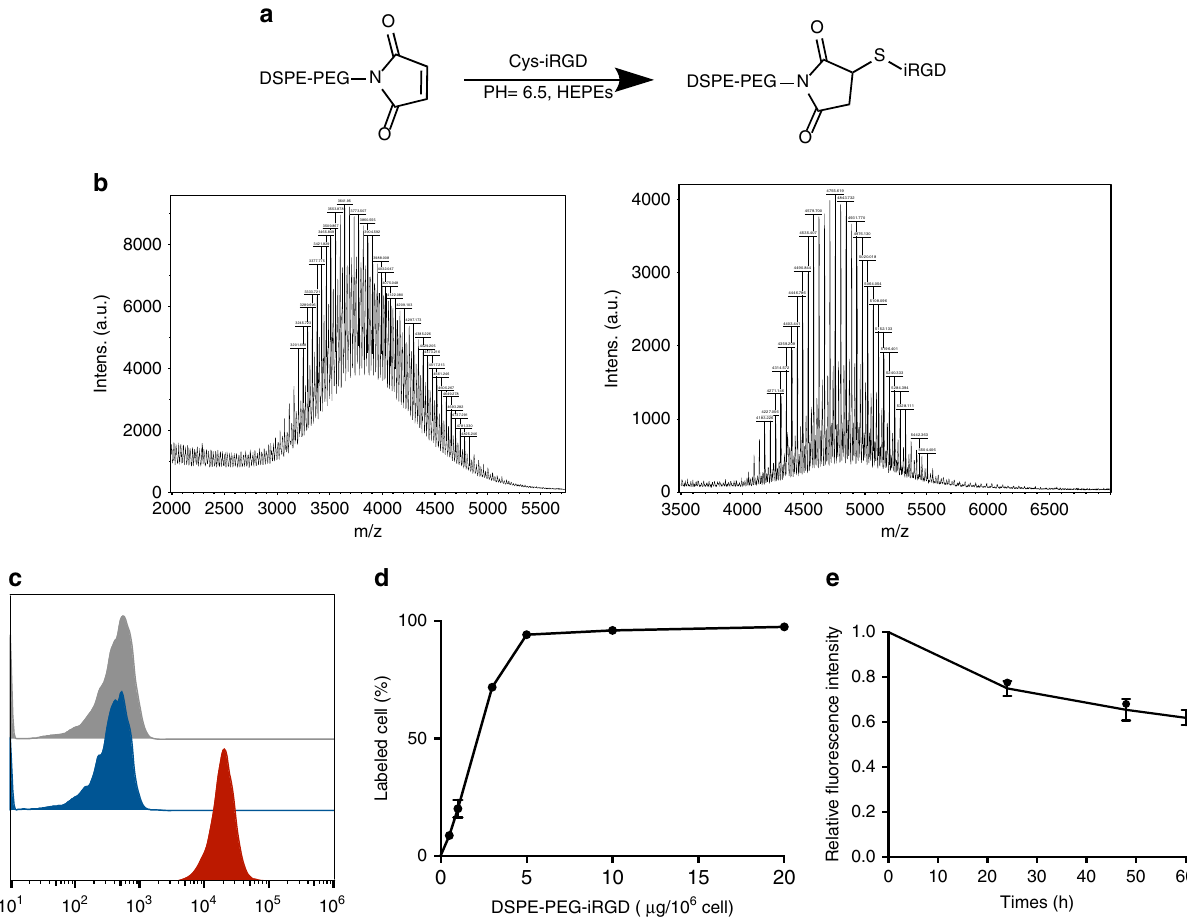
Fig. 1 Synthesis of DSPE-PEG-iRGD and cell-surface modi fi cation with DSPE-PEG-iRGD. a Schematic diagram of the synthesis of lipid-conjugated iRGD. b MALDI-TOF characterization of DSPE-PEG-Mal and DSPE-PEG-iRGD construct. The difference in molecular weight indicates the successful connection of iRGD and DSPE-PEG-Mal. c Flow cytometry histograms of T cells alone (grey) and the cells incubated with iRGD-FAM (blue) and DSPE-PEG-iRGD-FAM (red). d Analysis of the percentage of DSPE-PEG-iRGD-FAM modi fi ed cell using fl ow cytometry. e Flow cytometric analysis of changes in relative averaged fl uorescence intensities of cells modi fi ed with FAM-DSPE-PEG-iRGD over the culture periods. Data represent mean ± s.e.m.; n = 3. T + iRGD, T cells co- administered with free iRGD; T-iRGD, T cells modi fi ed with